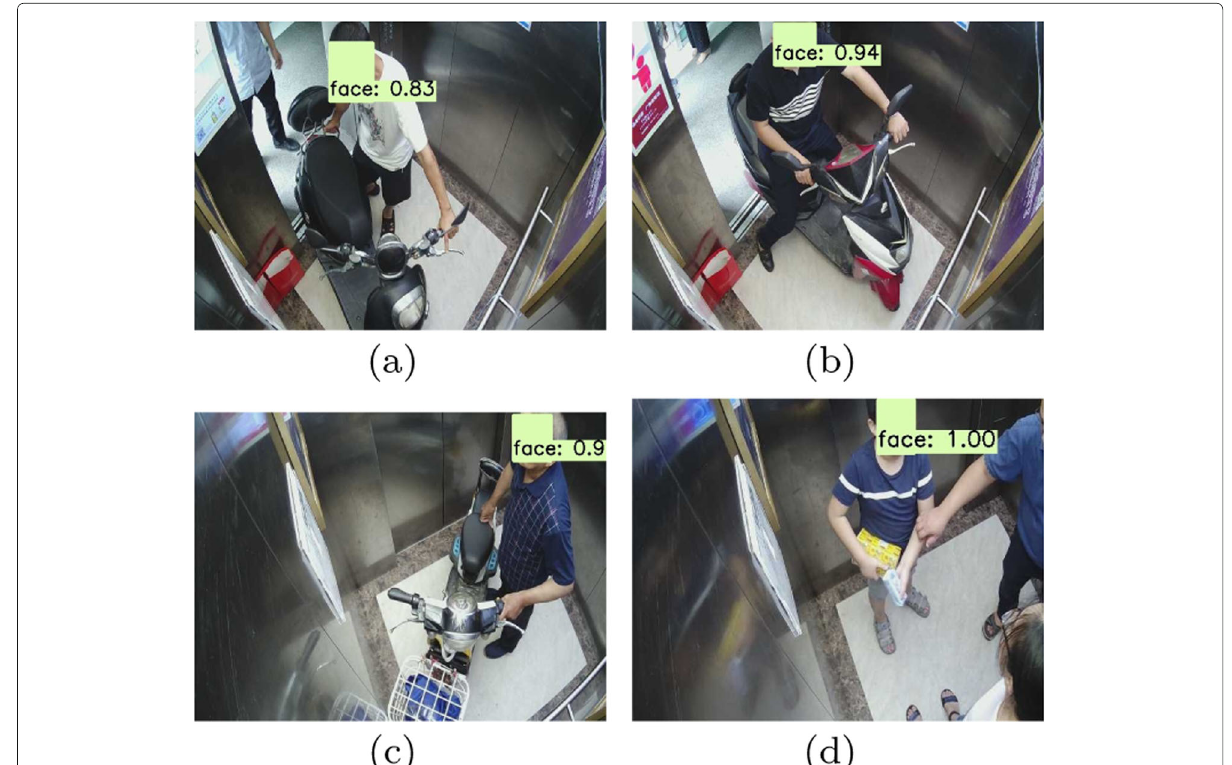
Fig. 3 Face coding to avoid location